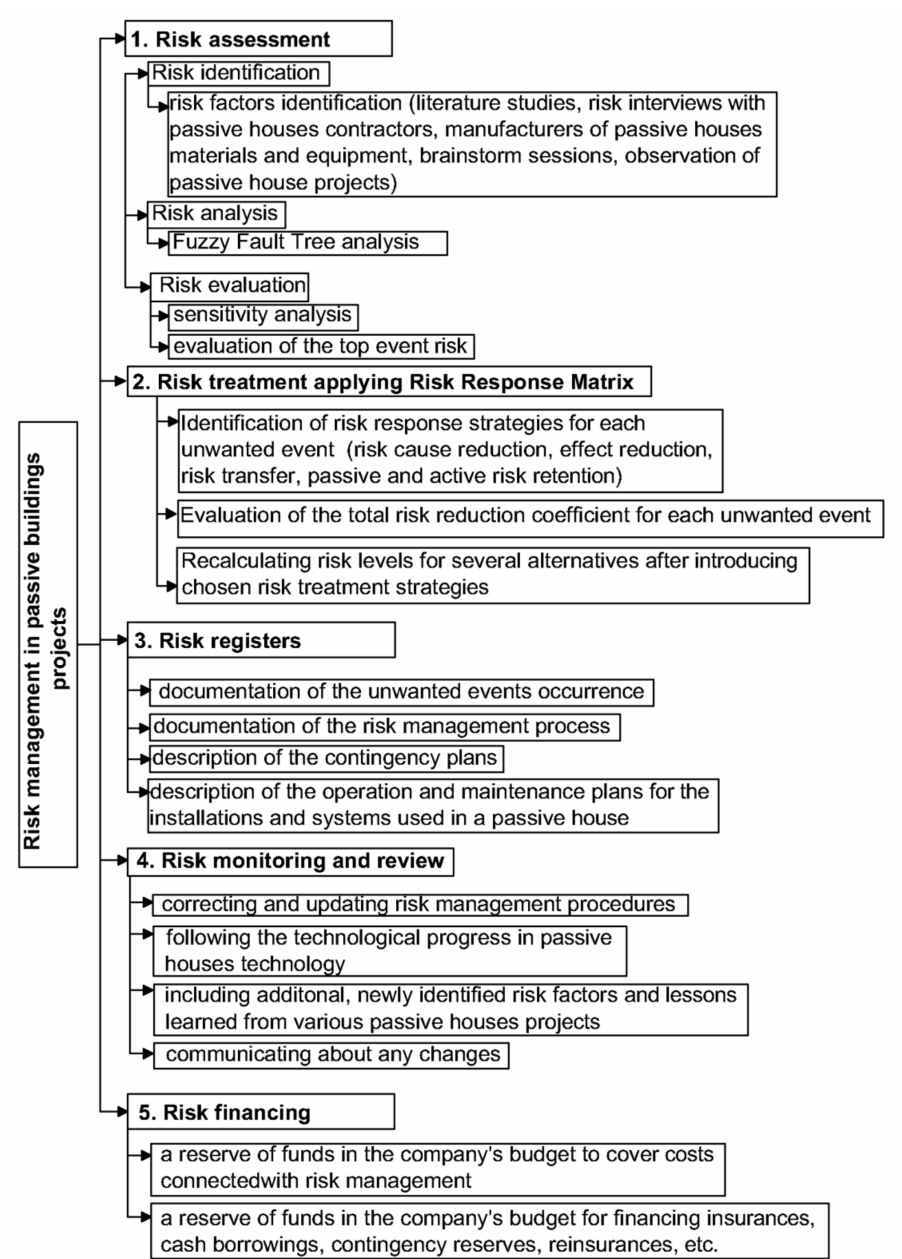
Figure 1. The proposed methodology of risk management in passive buildings